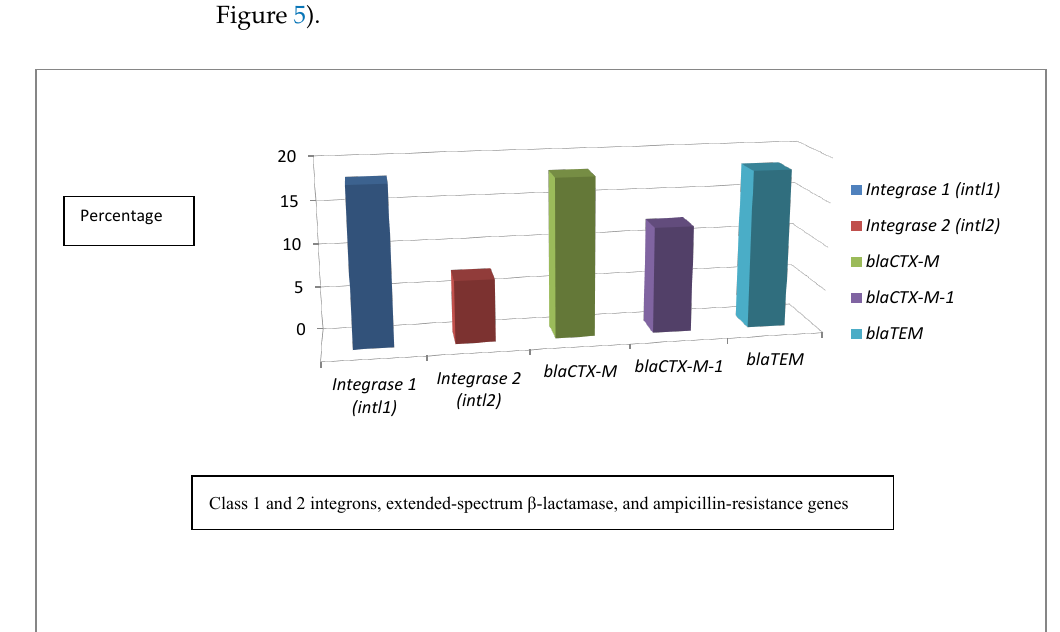
Figure 5. The results of class 1 and 2 integrons, extended- spectrum β -lactamase, and ampicillin-resistance genes. 2.8. Associations between Isolation Source, Strain, and Phenotypic and Genotypic